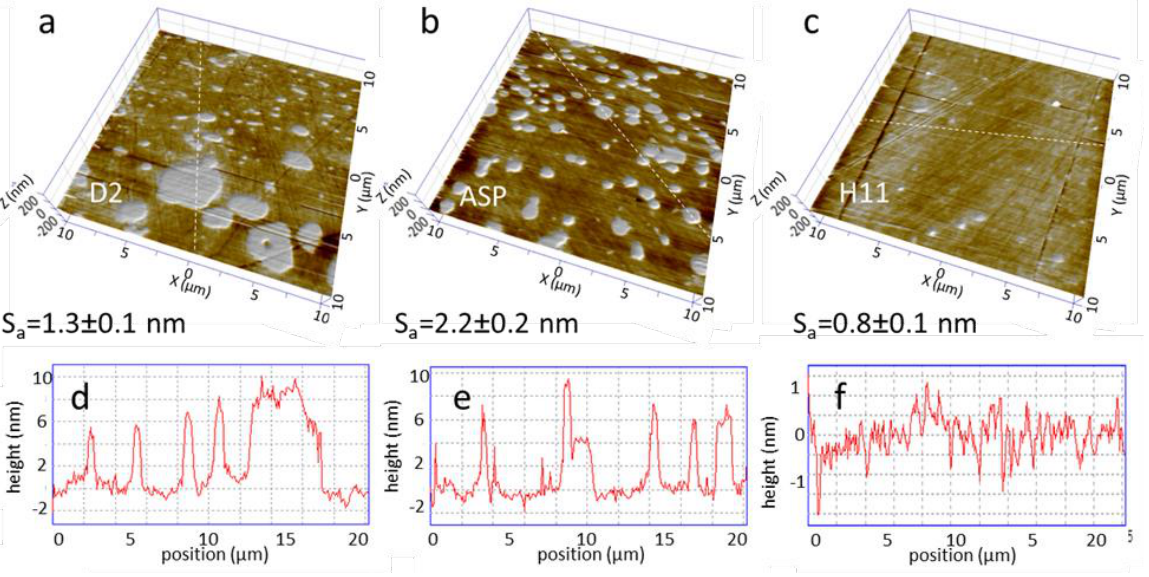
Figure 2. AFM images and surface roughness (S a ) of bare D2 ( a ), ASP30 ( b ) and H11 ( c ) tool steel substrates after polishing. The scan area was 20 µm × 20 µm, while the z-scale is 200 nm. Figures ( d – f ) show typical roughness profiles along the dashed lines in figures ( a – c ). Pay attention to the different z-scales.